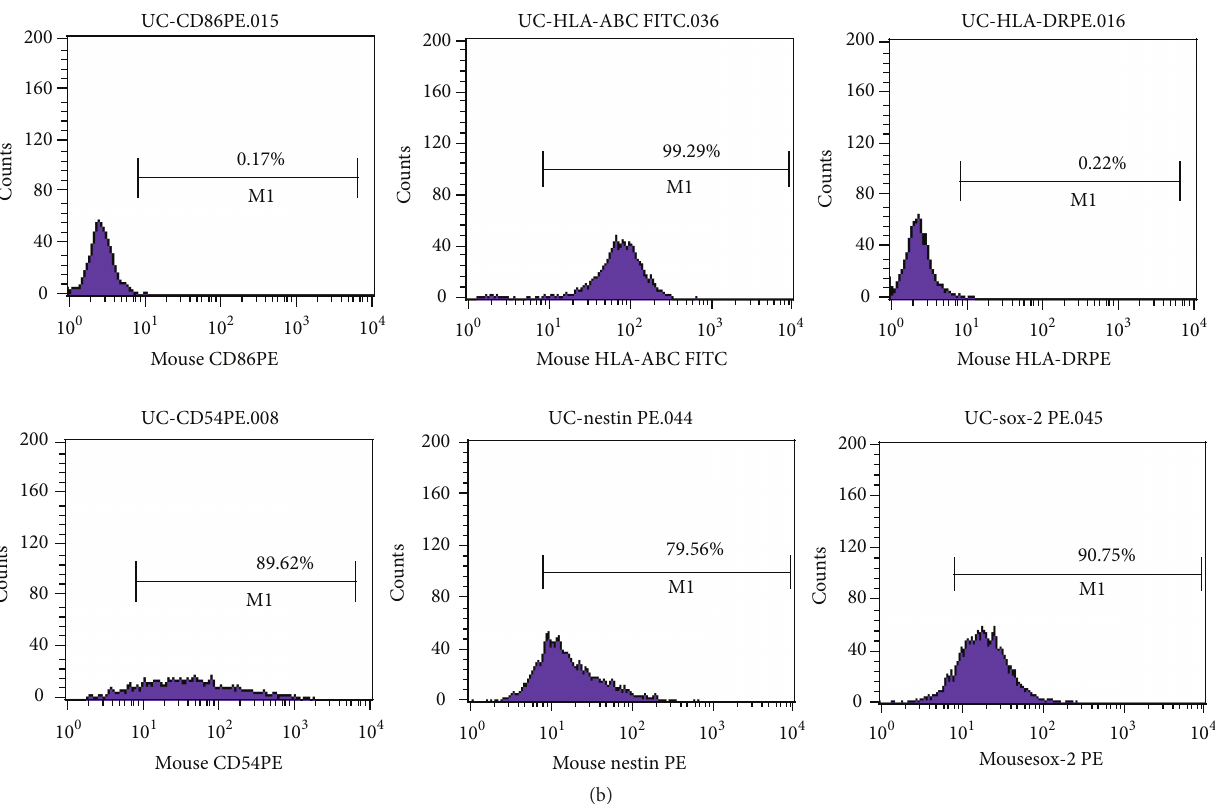
Figure 2: Immunophenotypes of UC-MSCs. UC-MSCs expressed CD29, CD44, CD54, CD73, CD90, CD105, CD106, HLA-ABC, nestin, and sox-2 but did not express CD11b, CD14, CD19, CD34, CD45, CD80, CD86, and HLA-DR. This figure shows one of the three independent experiments’ results.